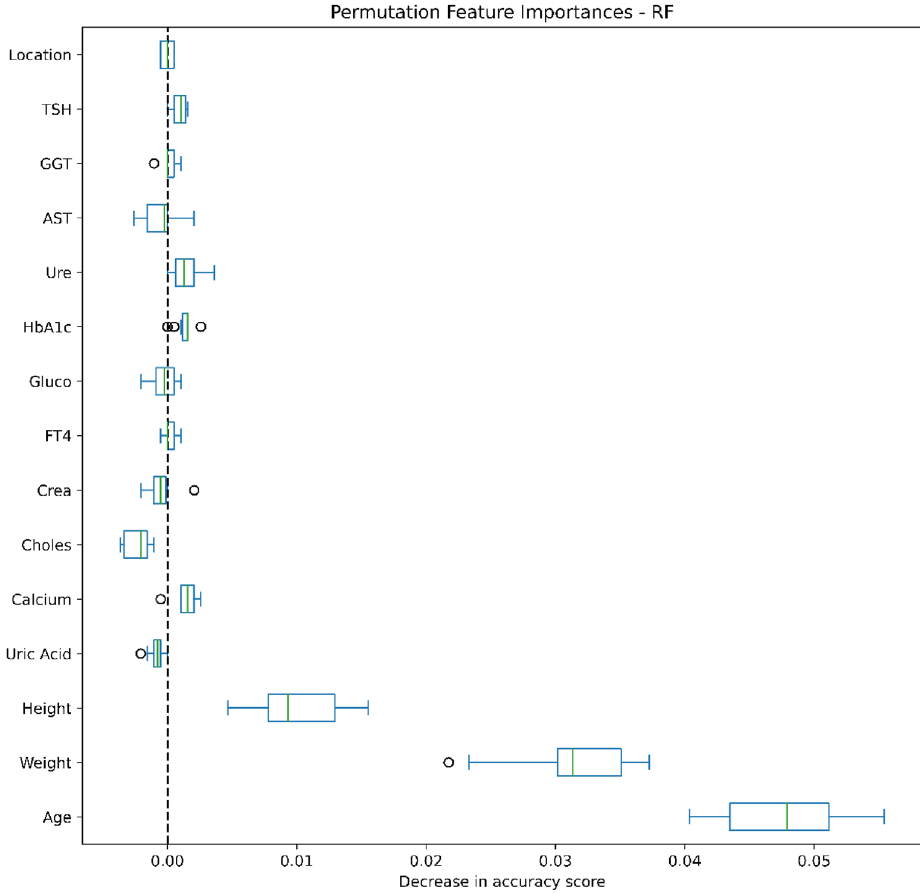
Figure 8. Feature importance for RF in the first